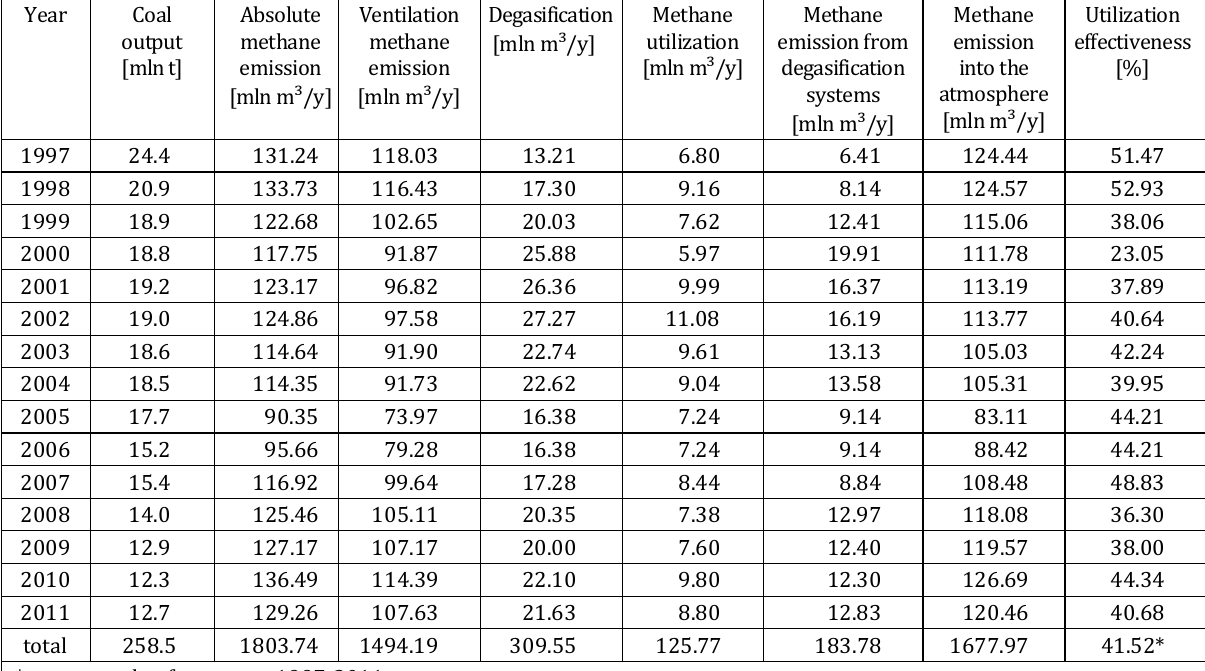
Table 2. The volume of absolute methane emission, degasification and coal-mine methane utilization from the mines of the Katowice Coal Company (KHW) in the period of 1997-2011, after Krause & Sebastian (1998-2012) Year Coal Absolute output [mln t]